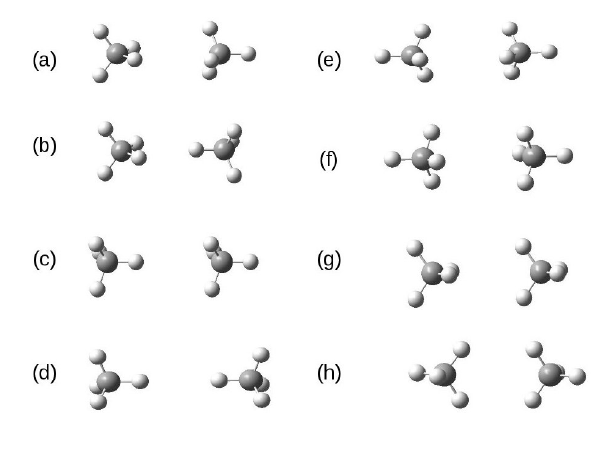
Figure 1. Methane dimer structures considered in this work.